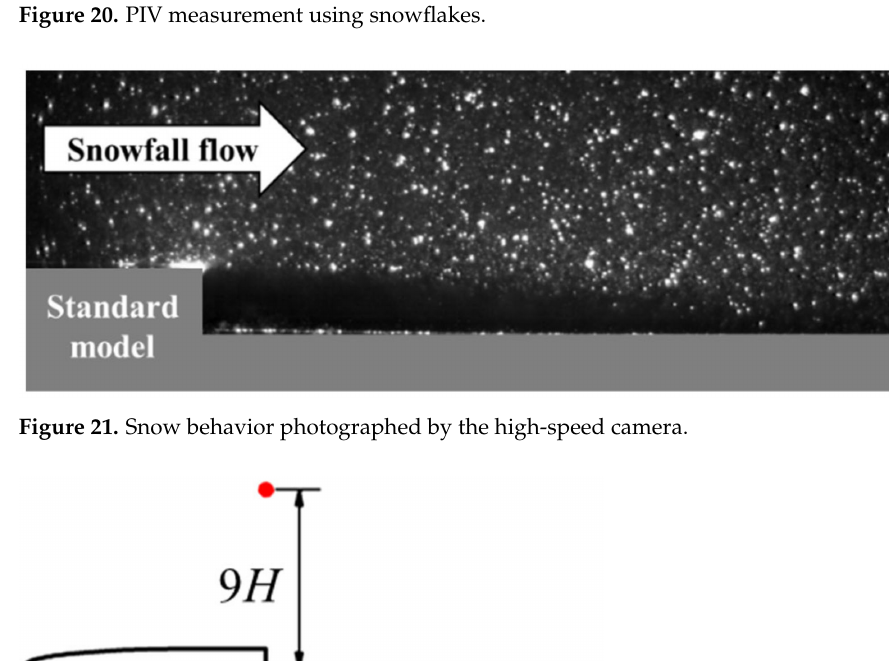
Figure 20. PIV measurement using snowflakes.